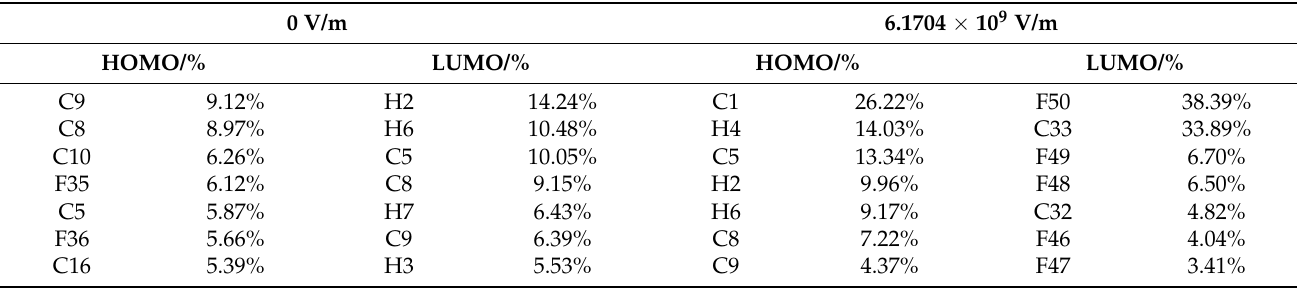
Table 1. Front track